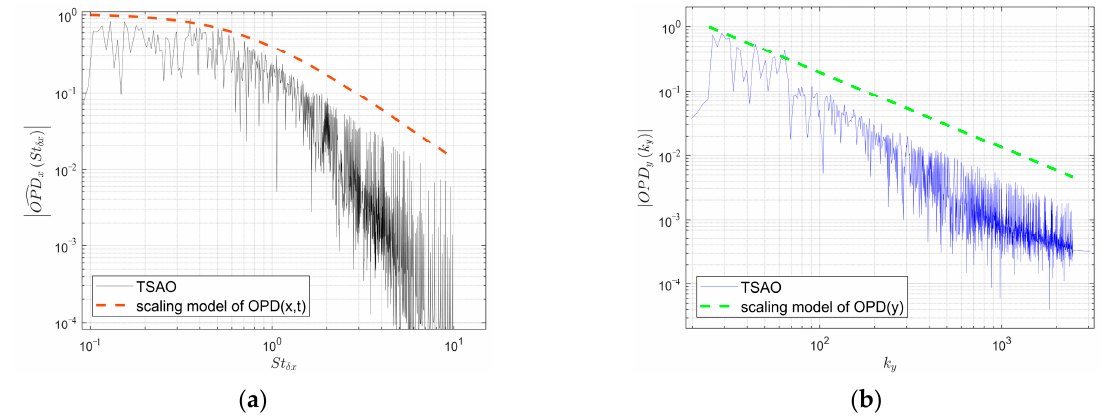
Figure 12. Amplitude spectra of the OPD from TSAO: ( a ) Streamwise; ( b ) spanwise.